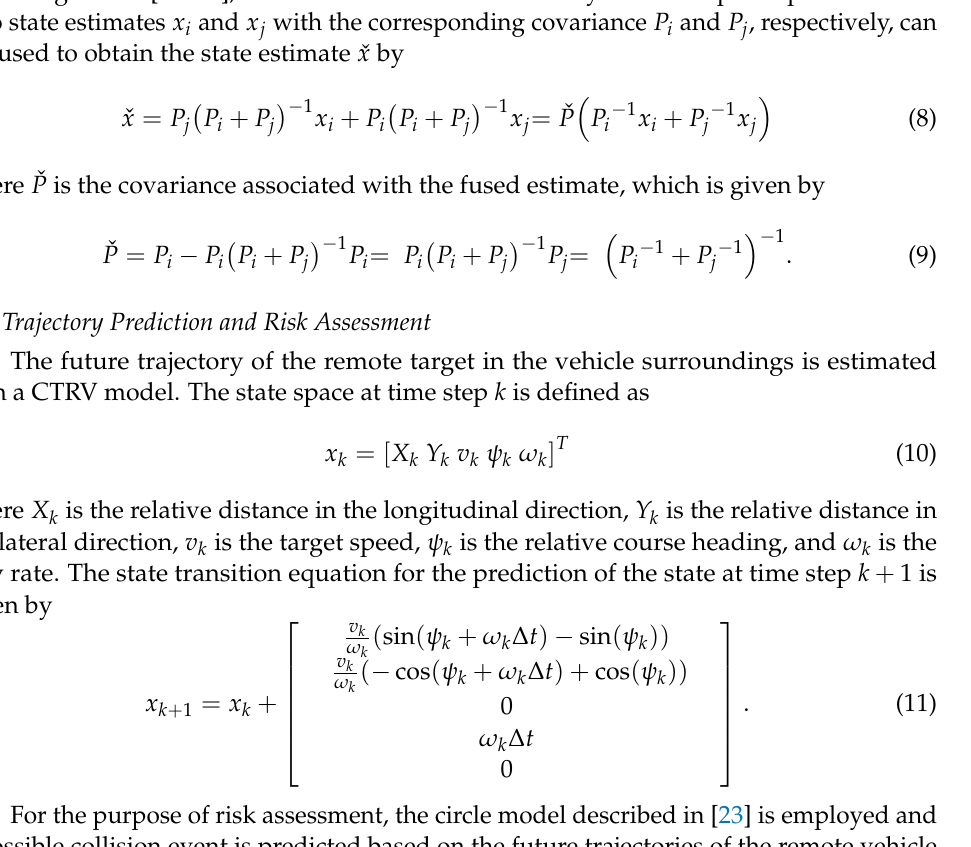
Figure 4. High-level fusion system architecture.